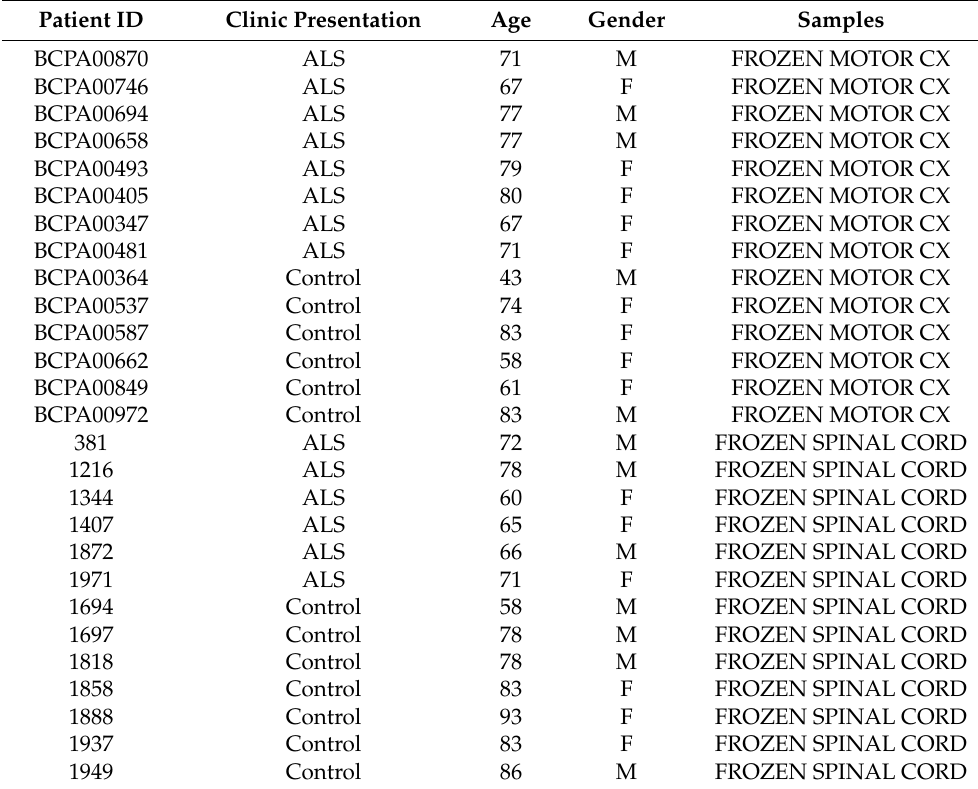
Table 1. List of human samples used in this study.